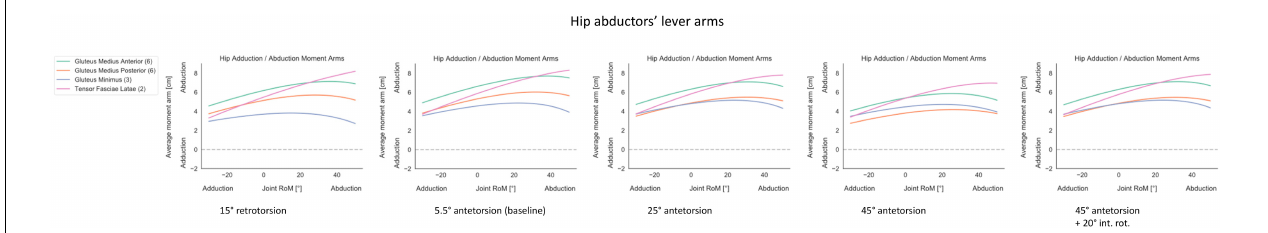
FIGURE 4 | Hip abductors’ lever arms were calculated for each individual muscle fascicle across a range of hip frontal motion (30 ◦ adduction, 50 ◦ abduction). Average lever arms were calculated for the fascicles constituting each muscle and the specific number of fascicles is reported in brackets next to the muscle’s name. Four different modelled femoral morphologies were compared: the baseline unmorphed model, characterized by a femoral antetorsion of 5.5 ◦ , as well as morphed femurs with retrotorsion of − 15 ◦ and antetorsion of + 25 ◦ and + 45 ◦ , reported as columns. Additionally, muscle lever arms were also calculated for the morphed femur with + 45 ◦ of ante-torsion and a fixed hip internal rotation angle of 20 ◦ (rightmost column), in order to mimic a compensatory kinematic strategy suspected to restore abduction capacity in pathological patients with torsional deformities. A complete overview of the changes in muscle lever arms is reported in Supplementary Figure 1